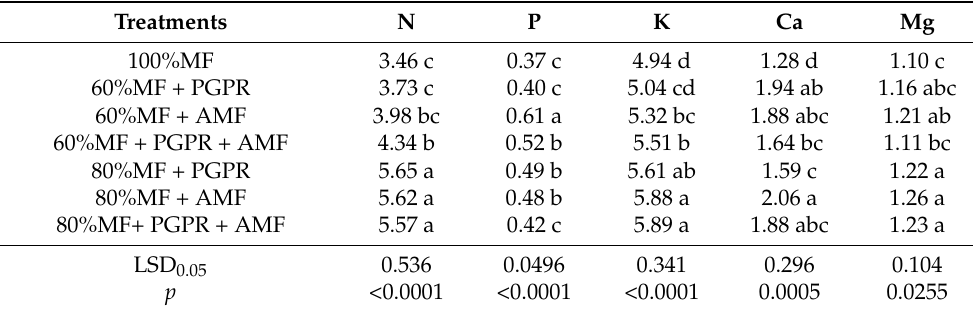
Table 6. Effects of the bio-fertilizers on pepper leaf macronutrient concentrations (%). Treatments N P K Ca